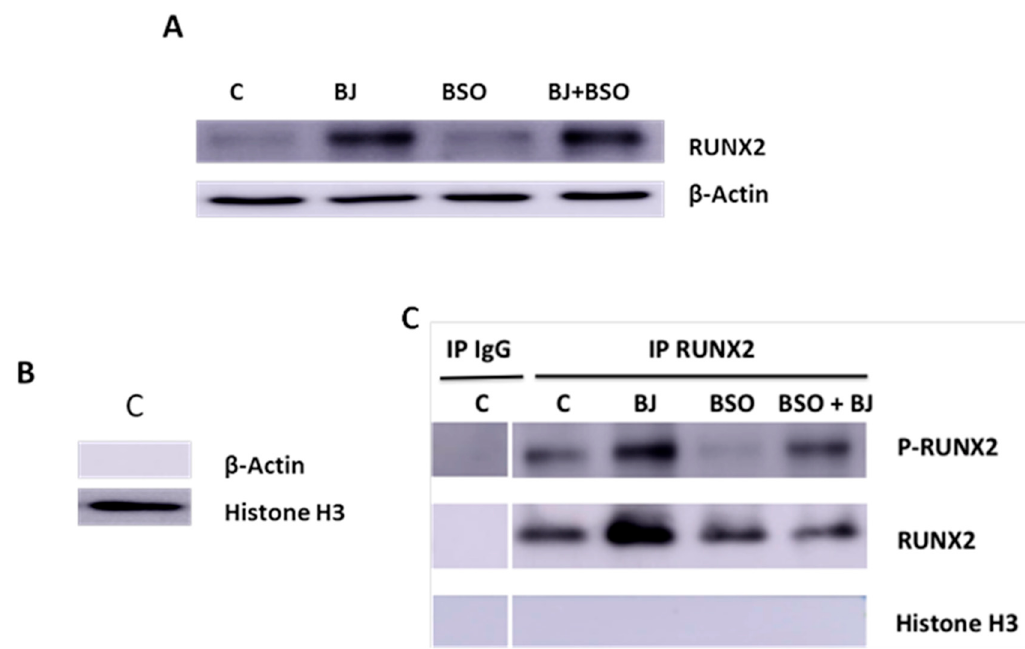
Figure 3. BJ effect on Runt-related transcription factor 2 (RUNX-2) expression and activation in BSO-treated and untreated SaOS-2 cells. RUNX-2 expression ( A ), nuclear fraction purification ( B ), and RUNX-2 activation ( C ) were detected in SaOS-2 cells treated or not with BJ at 15 μ g ∙ mL − 1 total soluble polyphenols (TSP) or BSO or BSO + BJ for one day in growth medium (GM) and, subsequently, for six days in osteogenic medium (OM), in the presence or not of various treatments, as reported in Section 2. RUNX-2 expression was detected by Western blot analysis in whole cellular lysate (A), RUNX-2 activation was detected by phosphorylation in immunoprecipitates of nuclear extracts using the anti-RUNX-2 antibody (C), and β -actin and histone H3 were detected in nuclear extract (B). RUNX-2, p-RUNX-2, β -actin, and histone H3 were revealed with anti-RUNX-2, anti-p-tyrosine proteins, anti- β -actin, or anti-histone H3, respectively. The blots are representative of three experiments .